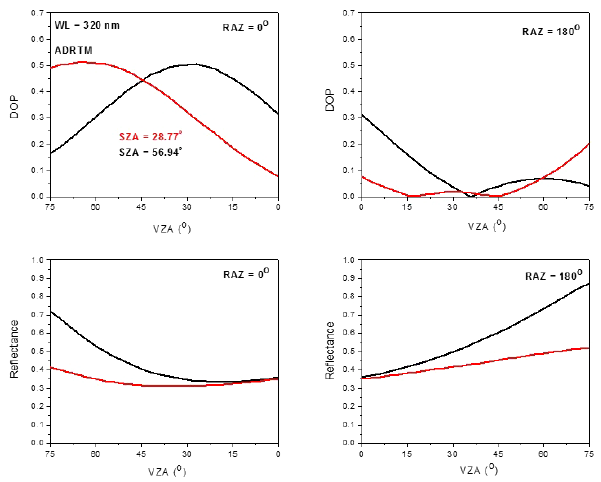
Figure 20. The modeled DOP and reflectance of desert-reflected solar light at RAZs of 0 and 180 ◦ at the wavelength of 320nm. The SZA is 28.77 and 56.94 ◦ , respectively, in the modeling.